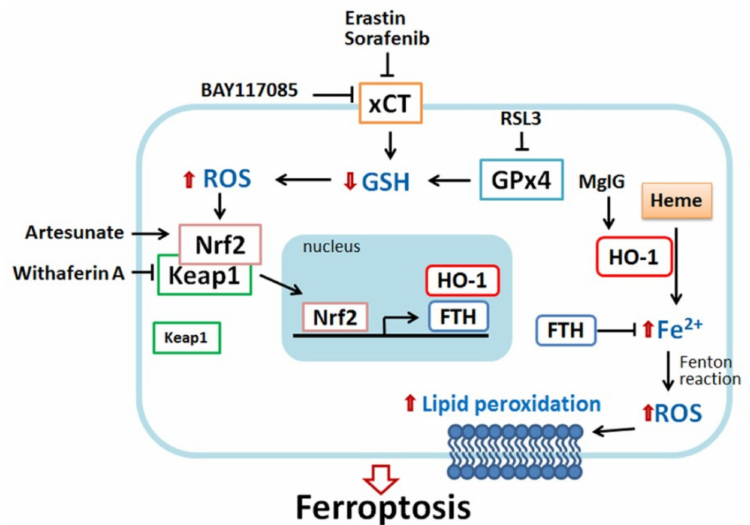
Figure 2. Scheme of HO-1-regulated ferroptosis. HO-1 plays a dual role in ferroptosis, pro-ferroptotic and anti-ferroptotic effects. Erastin and sorafenib (xCT inhibitor) and RSL3 (glutathione peroxidase 4 (GPx4) inhibitor) can deplete glutathione, leading to ROS generation. In response to oxidative